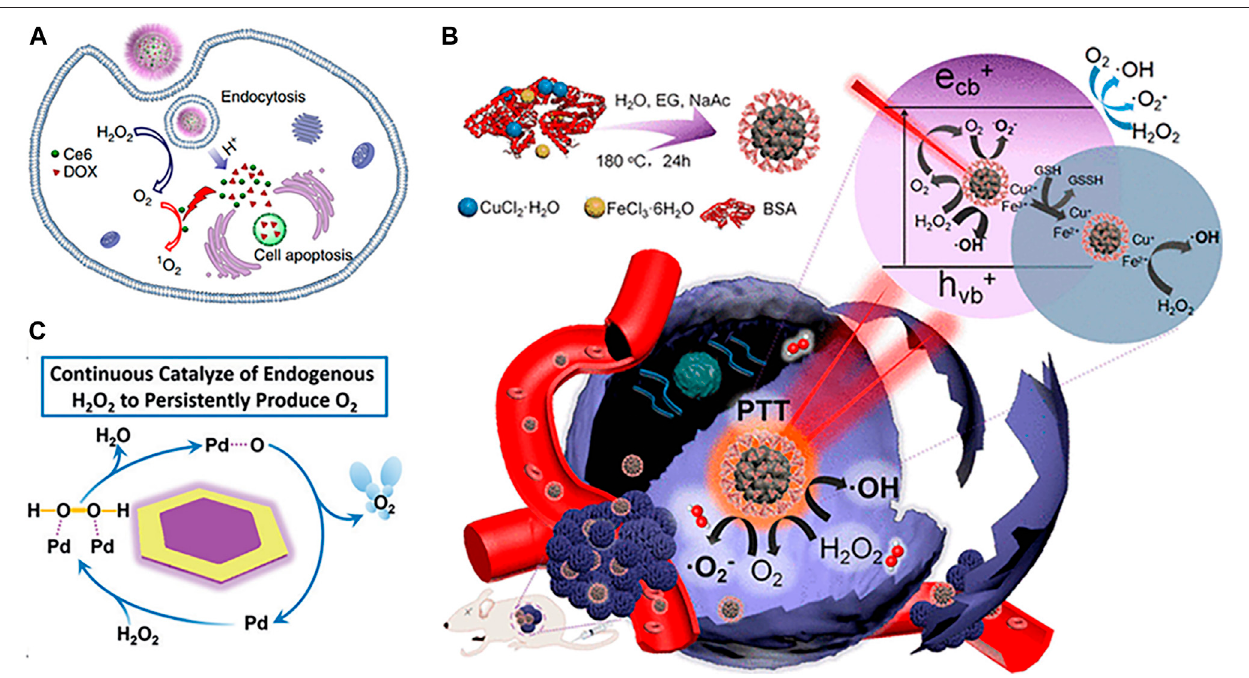
FIGURE 2 | (A) Schematic illustration of H-MnO 2 -PEG loaded with DOX and Ce6 for pH-responsive drug delivery and oxygen-elevated PDT (Yang et al., 2017) (Copyright 2017, reproduced with permission from Nature Publishing Group). (B) Schematic illustration of synthetic process and therapeutic mechanism of CuFe 2 O 4 nanospheres (Liu Y. et al., 2018) (Copyright 2018, reproduced with permission from American Chemical Society). (C) Schematic illustration of Pd@Au for catalysis of H 2 O 2 and continuous production of O 2 (Yang Y. et al., 2019) (Copyright 2016, reproduced with permission from John Wiley and Sons).